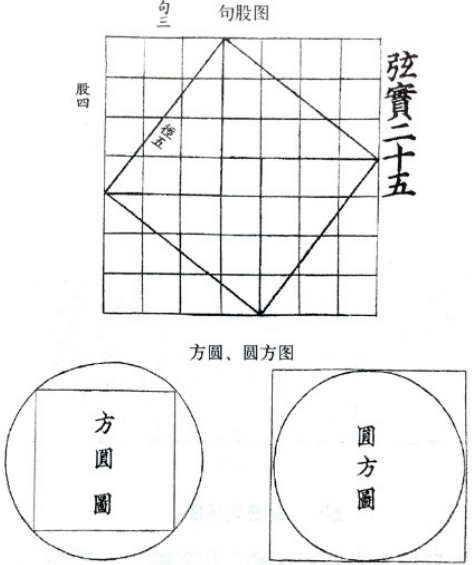
Figure 5. Line drawings of Gougutu ( 勾股圖 ) and Fangyuantu ( 方圓圖 ), Yuanfangtu ( 圓方圖 ), which were proposed by Shang Gao ( 商高 ).